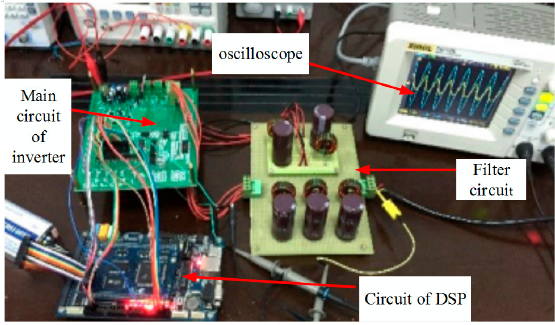
Figure 7. Photo of the hardware experimental platform.